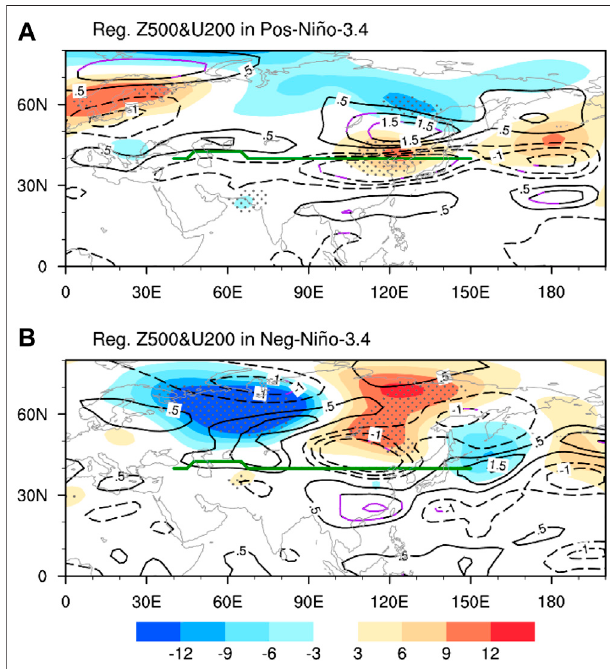
FIGURE 4 | Regression of summer 500-hPa geopotential height (shading, m) and 200-hPa zonal winds (contour interval: 0.5 m, zero contours are omitted) onto summer HK Prec for years with (A) a positive Niño 3.4 summer and (B) a negative Niño 3.4 summer. Stippling and purple contours indicate the 90% con fi dence level. The thick green line shows the climatological location of the westerly jet axis at 200 hPa.